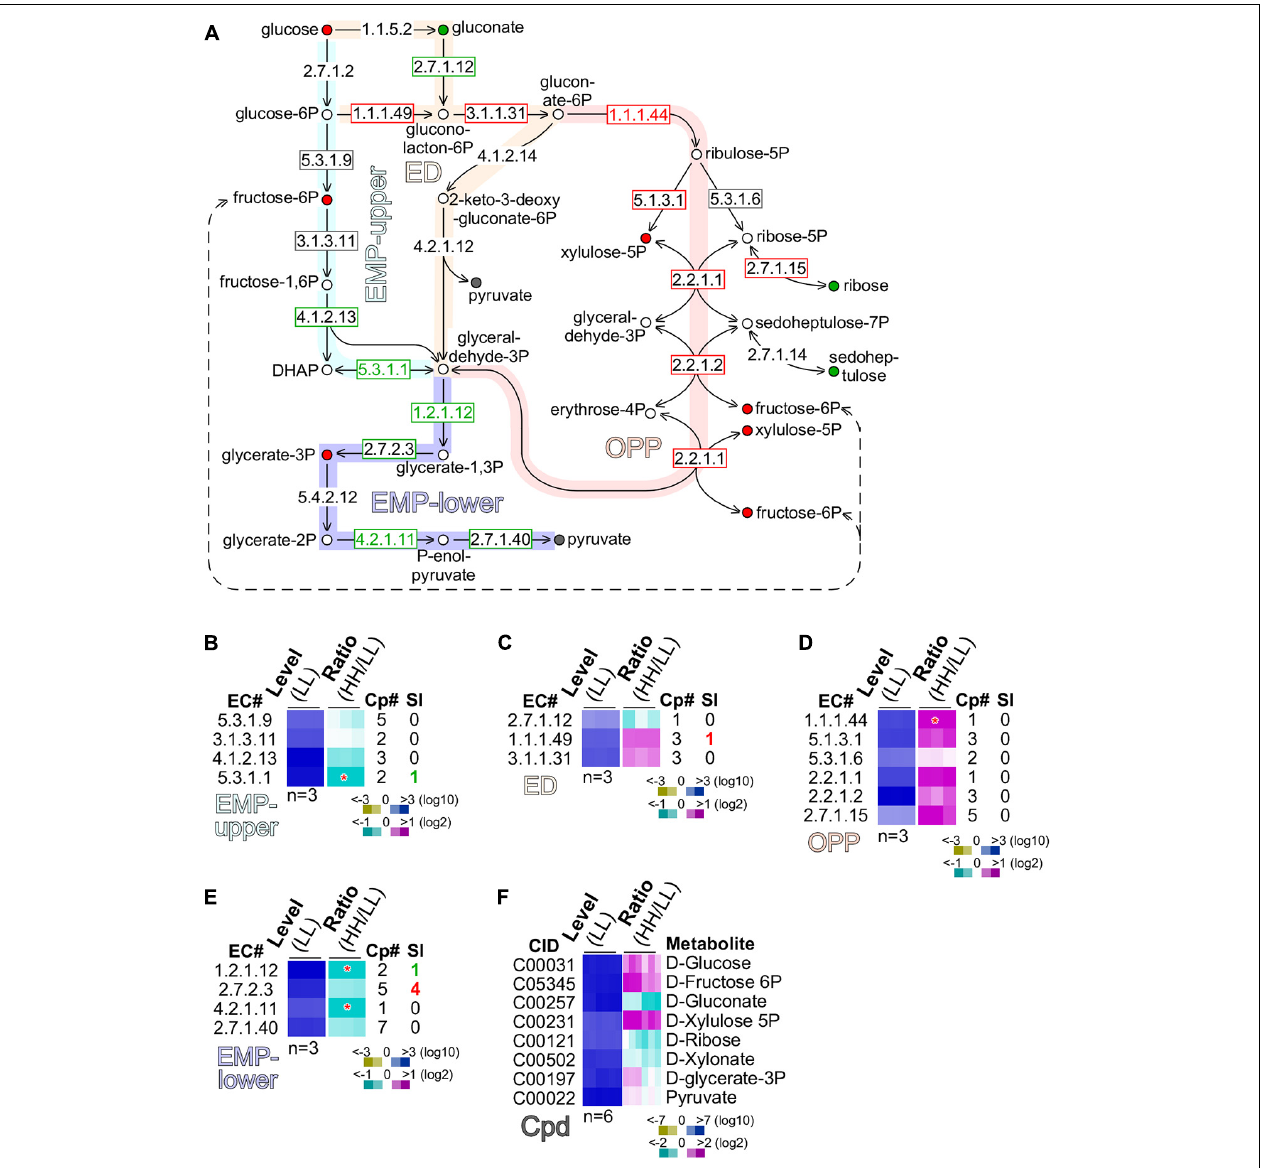
FIGURE 5 | Glucose is preferentially oxidized through the oxidative pentose phosphate (OPP) pathway. (A) Schematic drawing of the EMP (Embden–Meyerhorf–Parnas)-upper pathway, ED (Entner–Doudoroff) pathway, oxidative pentose phosphate (OPP) pathway, and EMP-lower pathway. Enzyme EC numbers with rectangular outline are shown. Enzymes without rectangular outline are not found in transcriptome. Significant (level change > 4-fold, p -value < 0.01) and moderate (level change > 1.2-fold) changes of enzyme levels are color coded with red, gray, and green of EC number and rectangular outline for upregulation, no change, and downregulation, respectively. Metabolites are shown as circle with color fill. Metabolites without color fill or white fill are not found in metabolome. Significant (level change > 4-fold, p -value < 0.01) and moderate (level change > 1.2-fold) changes of metabolite levels are indicated with red, gray, and green of circle outline and inner fill for upregulation, no change, and downregulation, respectively. (B) Heatmap of transcription level change of enzymes involved in MEP-upper. Heatmap is based on summative level of enzyme isoforms when available. Asterisk “*” sign indicates a significant change of summative levels (level change > 2-fold, p -value < 0.05) change. Magenta, white, and cyan stand for upregulation, unchanged, and downregulation of transcription, respectively. Total number of isoform copies (Cp#) is shown. Number of significantly changed isoforms (SI) is also shown. Color keys are shown in the bottom. Heatmap of profiles of enzymes involved in (C) ED, (D) OPP, and (E) EMP-lower are shown. The display is identical to (B) . (F) Heatmap of profiles of metabolites involved in the above pathways is shown. CID stands for compound ID.